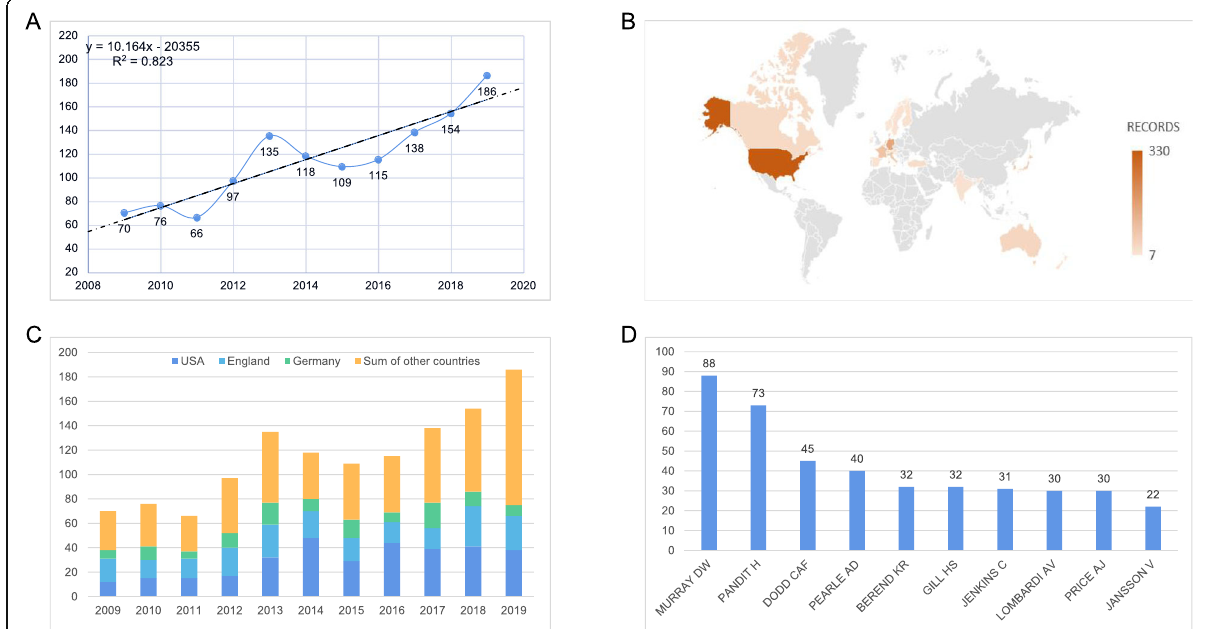
Fig. 2 UKA publication: a : The model fitting curves of growth trends of UKA publication; b :Top 10 countries by volume; c : Top 3 countries by volume; d : Top 10